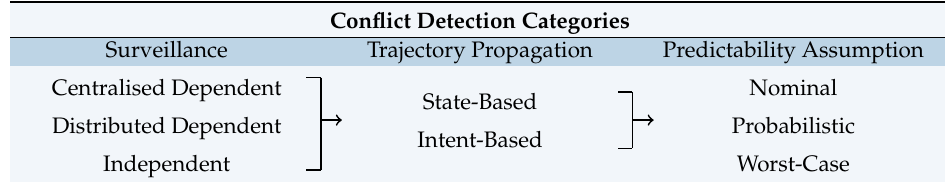
Table 1. Taxonomy of conflict detection categories.